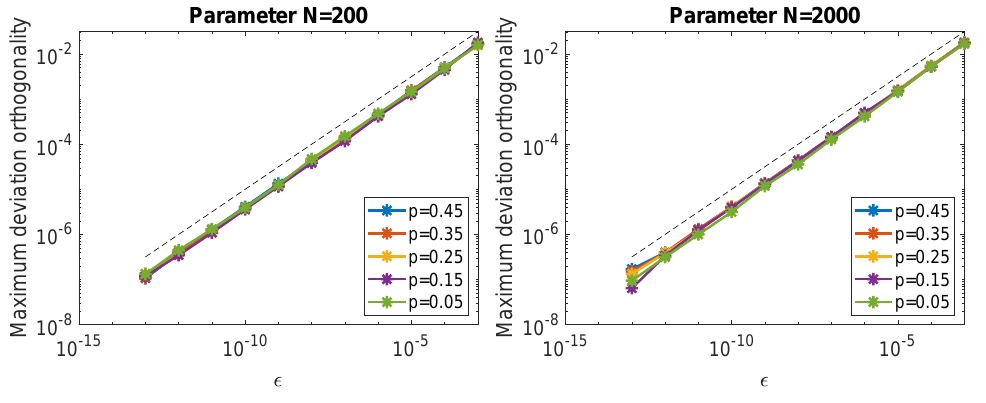
Figure 5. Maximum deviation from orthogonality for two different segment sizes and various values of p as a function of the allowed